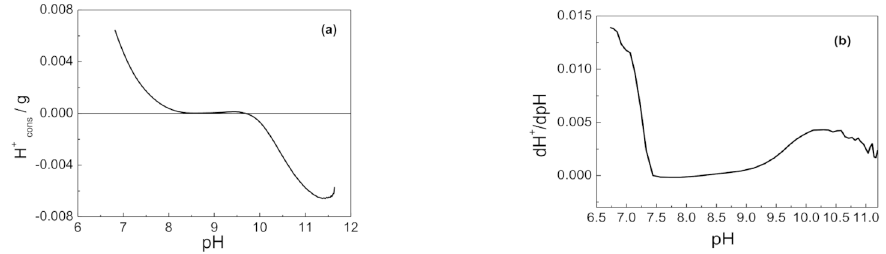
Figure 8. ( a ) H + consumed by the surface as a function of the pH solution; ( b ) the differential curve of the H + consumed with